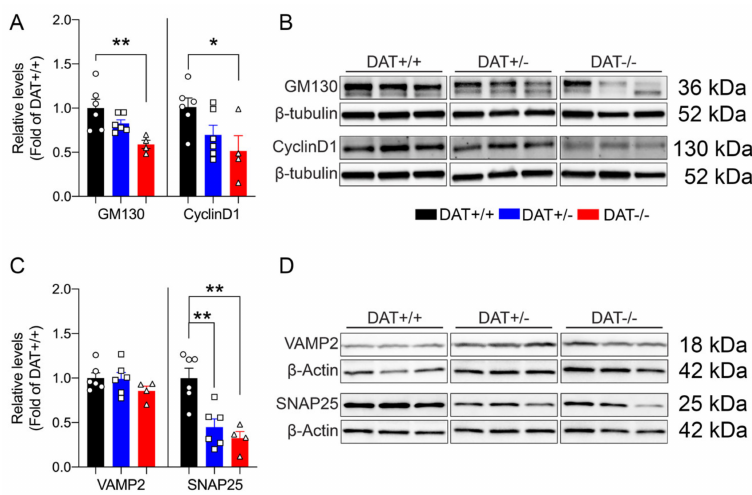
Figure 2. E ff ects of DAT ablation on the cellular regulation and exocytotic machinery of the pituitary gland. ( A ) Full DAT ablation (DAT - / -) reduced protein levels of GM130 and CyclinD1. ( C ) DAT ablation did not alter VAMP2, but reduced protein levels of SNAP25 for both DAT +/ - and DAT- / - rats. ( B , D ) Immunoblots from representative rats in each group are shown (PND60). Data were normalized to β -tubulin or β -actin, relative to control (DAT +/+ ). Data were expressed as mean ± SEM ( n = 4–6), * p < 0.05, ** p <